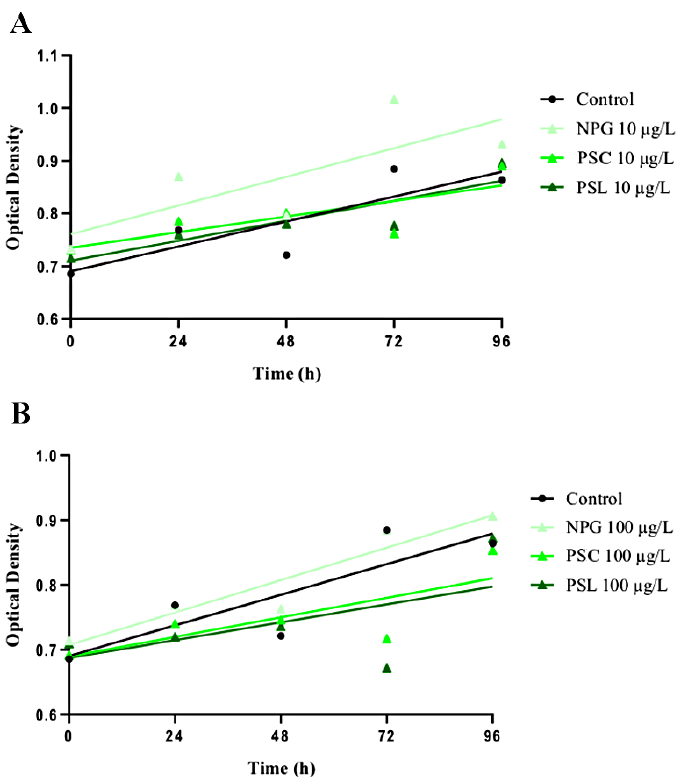
Figure 1. Tisochrysis lutea growth cultured in F/2 medium for 96 h. Linear regressions with mean points ( n = 5) are represented for 10 µg L −1 NP treatments ( A ) and 100 µg L −1 NP treatments ( B ). Regression coefficients ( A ) are control = 0.74, NPG = 0.60, PSC = 0.61, PSL = 0.80. Regression coefficients ( B ) are control = 0.74, NPG = 0.90, PSC = 0.59, PSL =